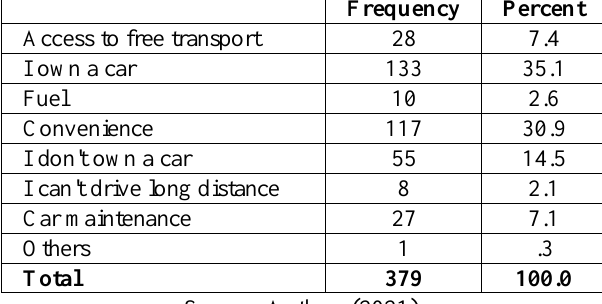
transportation of